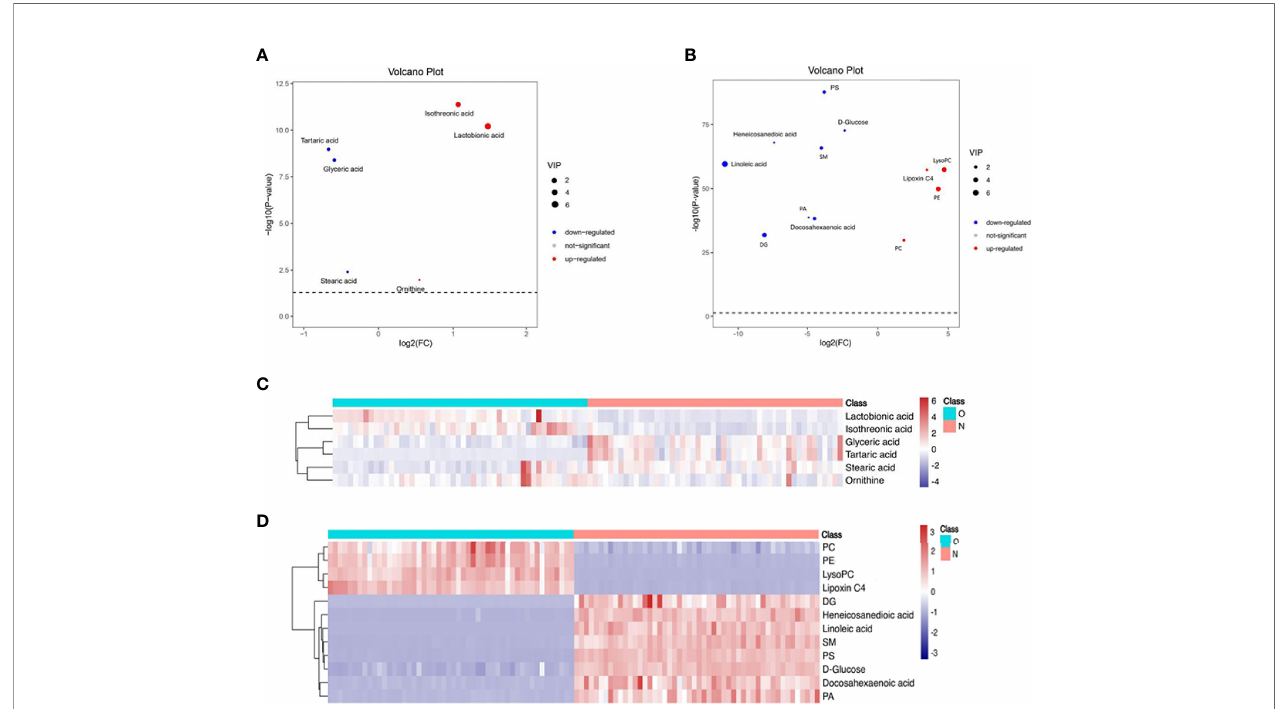
FIGURE 2 | Volcano plot and hierarchical clustering based on the GC/LC-MS of serum metabolites obtained from the case group (O blue) and healthy control group (N red). (A) Volcano plot based on GC-MS. (B) Volcano plot based on LC-MS. (C) Hierarchical clustering based on GC-MS. (D) Hierarchical Clustering based on LC-MS. In (A, B) , the blue dot represents metabolite with a downward trend, red represents metabolites with an upward trend, and the gray origin represents that the change of metabolites is not obvious. The area size of the point is related to the VIP value. In (C, D) , the color from blue to red illustrates that metabolites ’ expression abundance is low to high in hierarchical clustering. PC, phosphatidylcholine; LysoPC, lysophosphatidylcholine; PE, phosphatidylethanolamine; DG diacylglycerol; PS, phosphatidylserine; SM, sphingomyelin; PA, phosphatidic